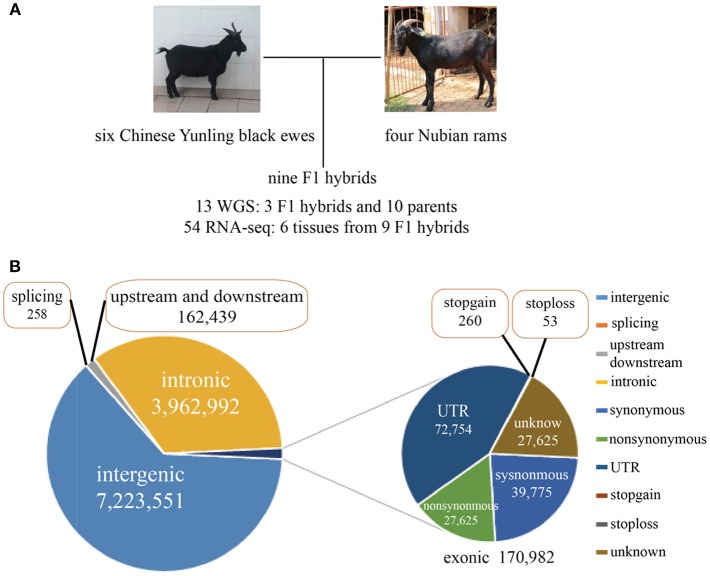
(A) Experimental design and brief data summary. (B) Statistics regarding the location and mutation type of the whole-genome SNPs.